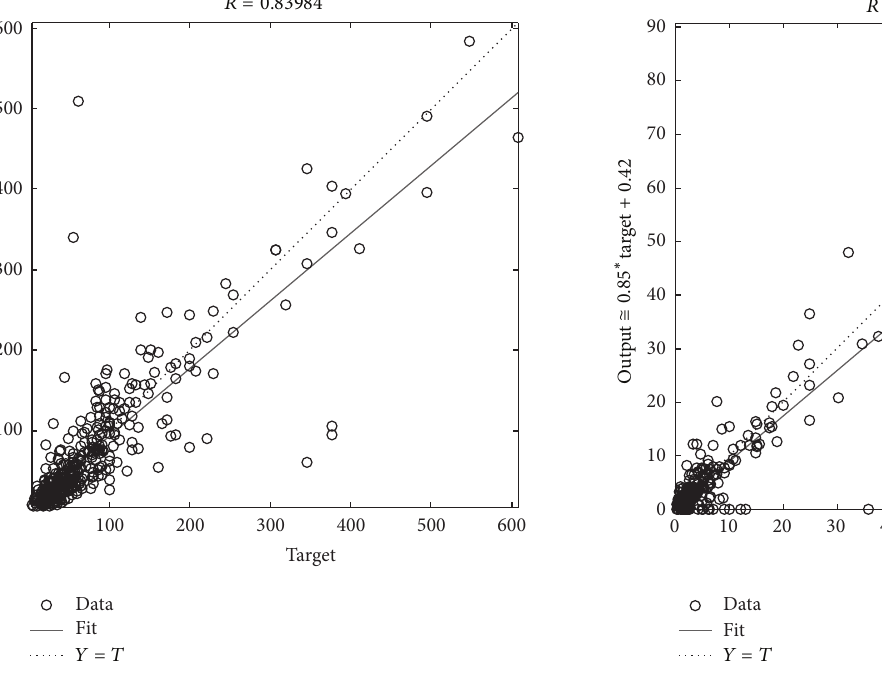
Figure 6: GP steel expression no. 5. Figure 7: GP zinc expression no.